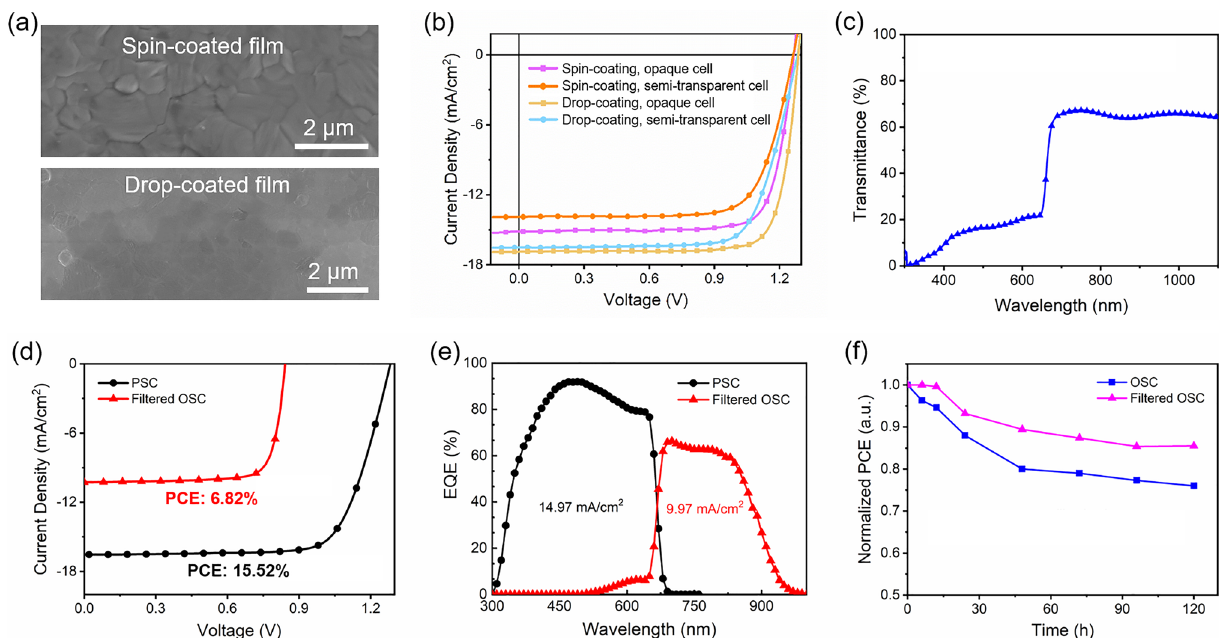
Fig. 5 a SEM images for inorganic perovskite films made by spin-coating and drop-coating. b J–V curves for opaque and semi-transparent CsPbI 2.25 Br 0.75 solar cells made by spin-coating and drop-coating. c Transmittance spectrum for the semi-transparent CsPbI 2.25 Br 0.75 solar cell. d and e J–V curves and EQE spectra for the semi-transparent CsPbI 2.25 Br 0.75 cell and filtered organic (D18-Cl-B:N3:PC 61 BM) cell. f PCE change for stand-alone OSCs and filtered OSCs under continuous 1-sun